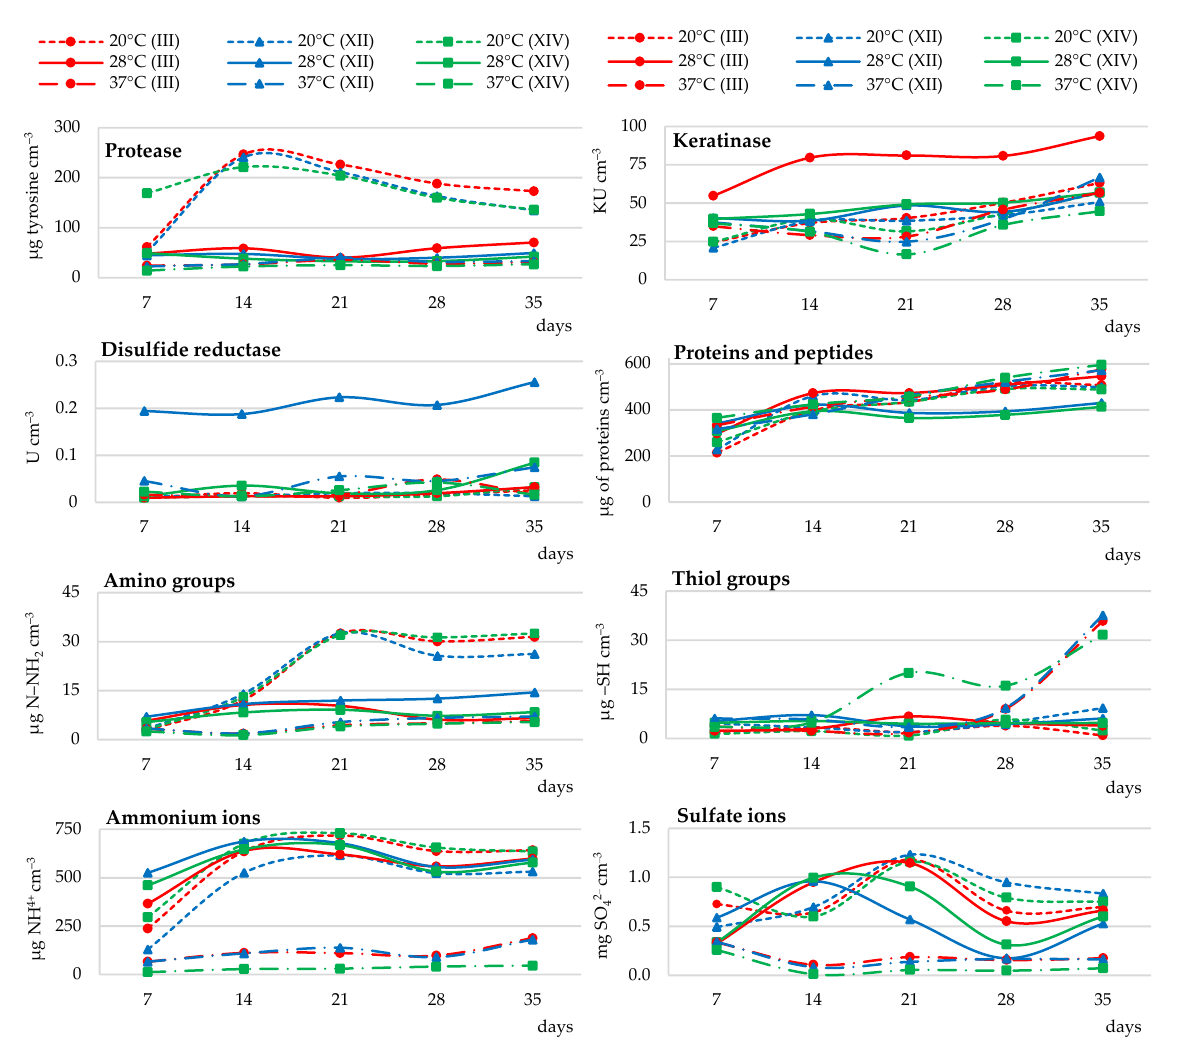
Figure 4. Dynamics of changes in enzymatic activity and released organic and mineral keratinolysis products in different culture temperatures of three Trichophyton ajelloi strains III, XII, and XIV. Release of Soluble Proteins, Peptides, and Amino Acids